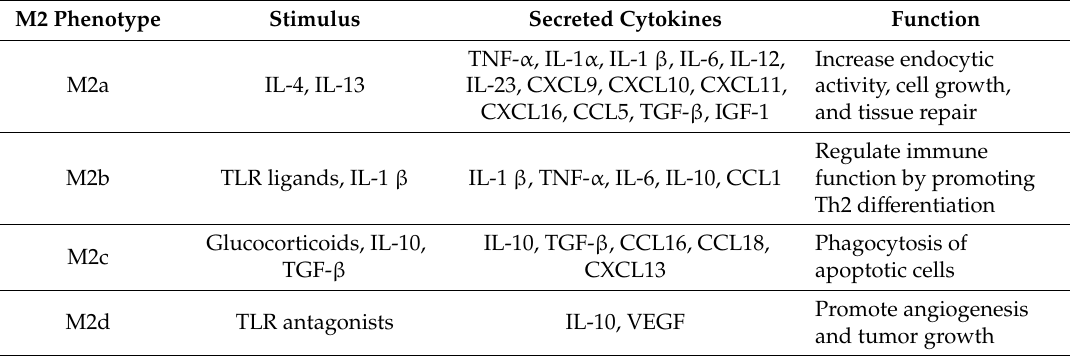
Table 1. M2 Macrophage phenotypes and their di ff erent stimuli, secreted cytokines, and functions. M2